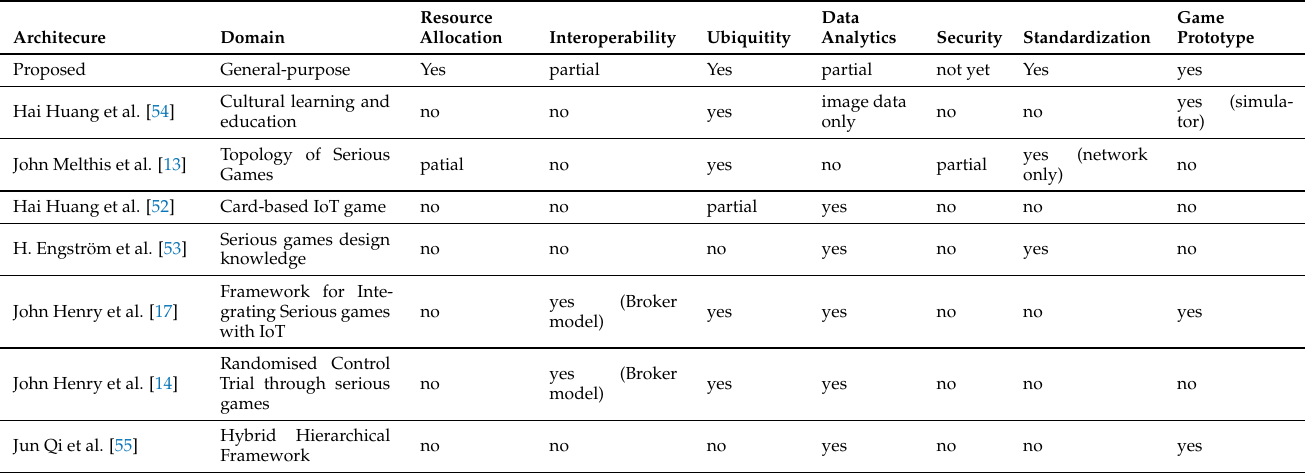
Table 7. Qualitative evaluation of the recent work towards the integration of serious games in the